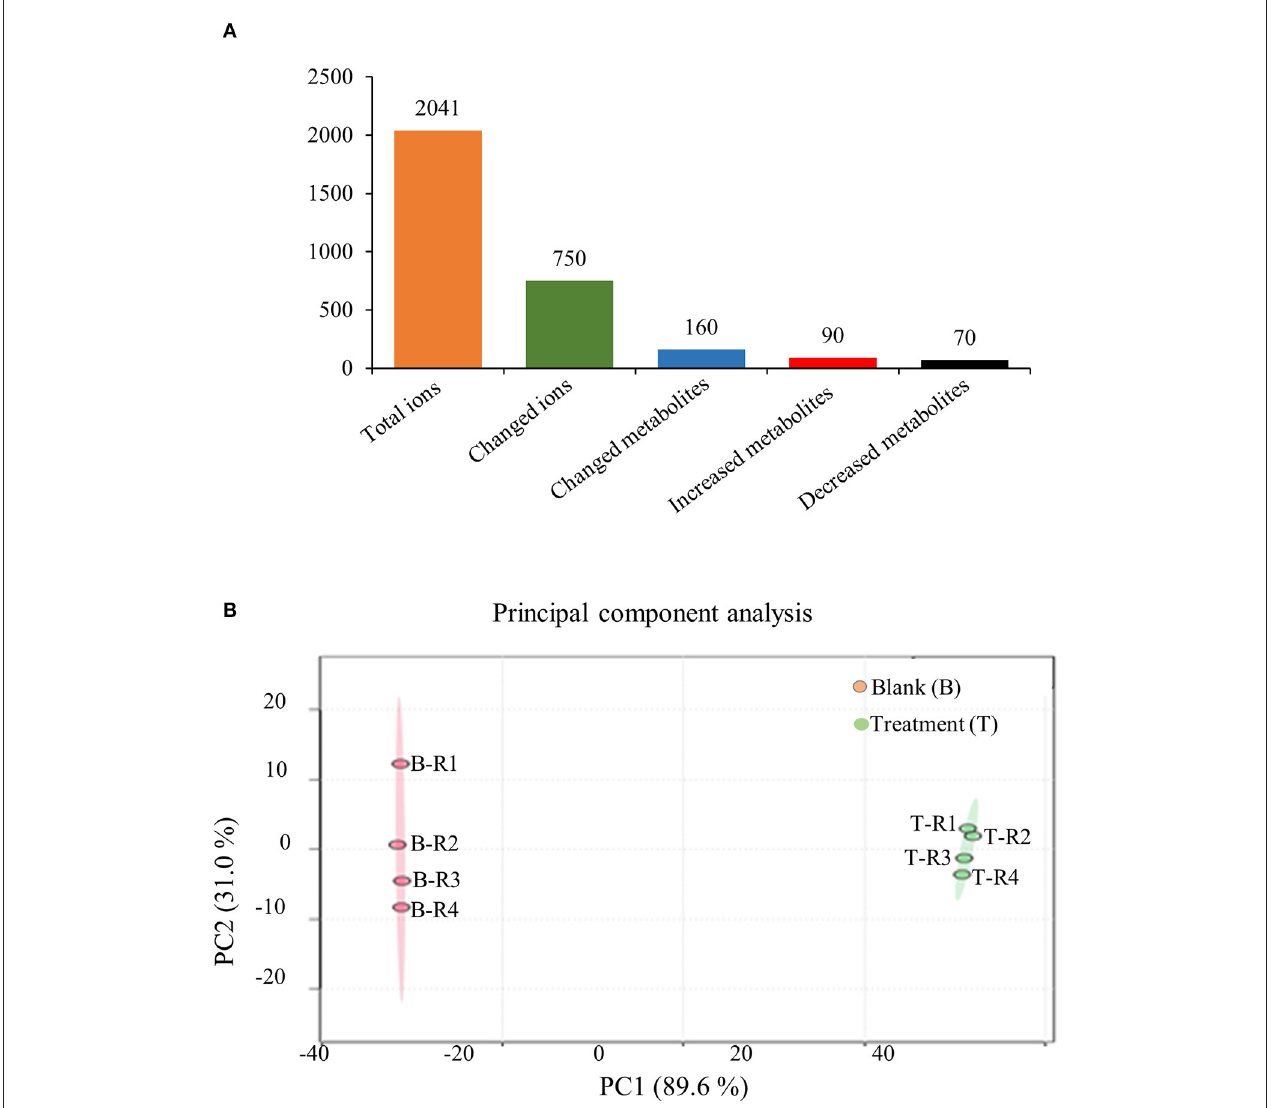
FIGURE 2 | Metabolomic analysis of low concentration of copper ion (LCCI) on the biosynthesis of salvinolic acids (SalAs) in Salvia miltiorrhiza . Two-month-old S. miltiorrhiza was treated with CuSO 4 .5H 2 O (5 µ M) for 5 days. Metabolites were extracted from roots and subjected to metabolomics analysis by untargeted ultra-performance liquid chromatography-quadrupole-time of flight mass spectrometry (UPLC-Q/TOF-MS). The total ions were counted within 90min. (A) The statistical number of identified ions, metabolites, and significantly changed metabolites is listed. (B) Principal component analysis (PCA) and a volcano plot based on identified ions in control and treated samples. To characterize their ion profiles, the identified ions were estimated using a principal component analysis. The significantly changed ions are depicted with a volcano plot. Red dots indicate significantly changed